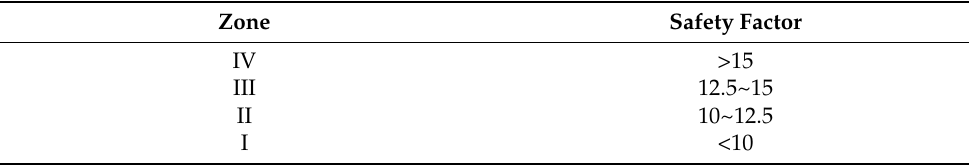
Table 5. Criteria of adjacent influential partition based on safety